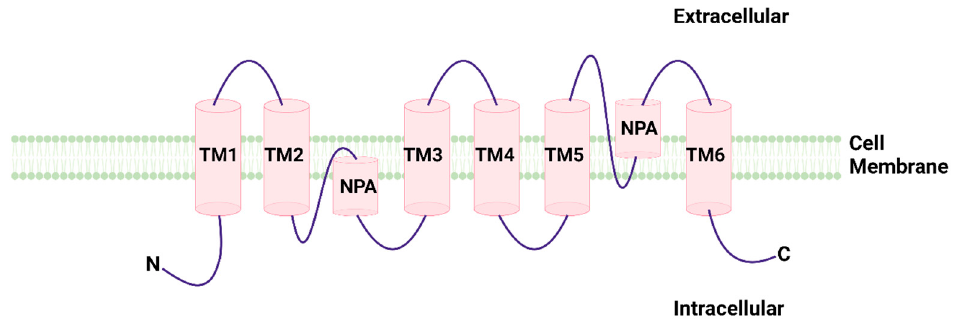
Figure 1. Structural model of aquaporins formed by six transmembrane helices and two helix-forming re-entrant loop containing the signature NPA motif.